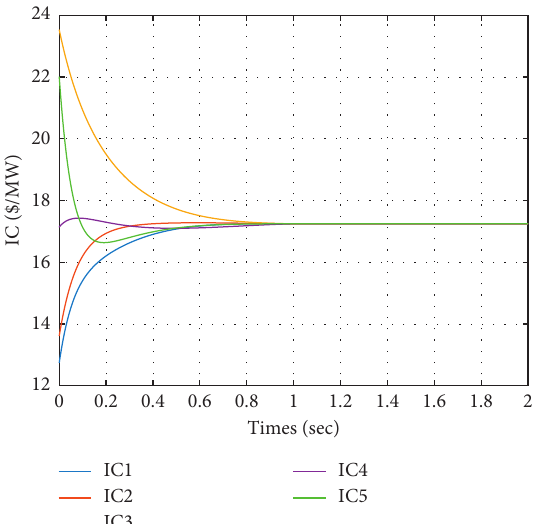
Figure 11: The incremental cost of generator λ effect.